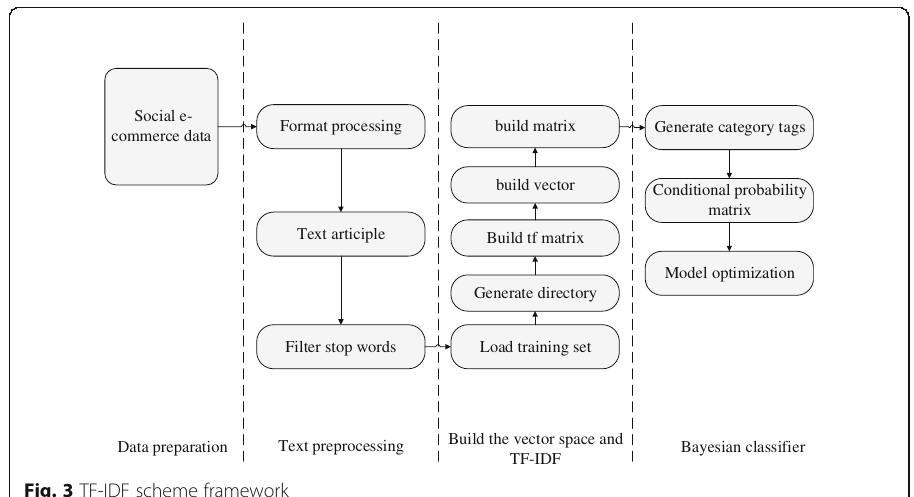
Fig. 3 TF-IDF scheme